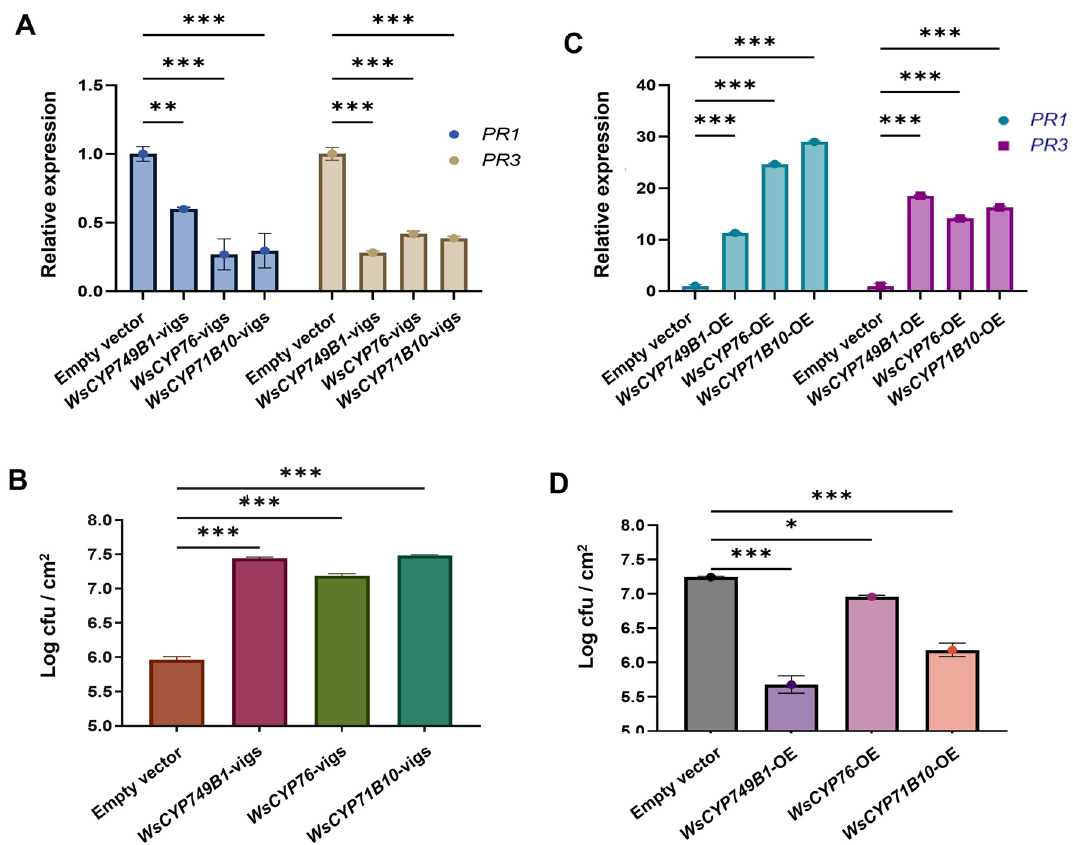
Figure 5. Effect of VIGS and overexpression of WsCYP450s on defense. Expression of PR genes in WsCYP450s silenced ( A ) and overexpressing ( C ) W. somnifera leaves. Expression levels of genes were normalized to 18S rRNA and are represented as expression relative to the empty vector (EV) control, which was set to 1. Pseudomonas syringae growth assay in WsCYP450s silenced ( B ) and overexpressing ( D ) W. somnifera leaves. Growth assay was performed by infiltrating leaves of control and VIGS plants with P. syringae (DC3000). CFU was calculated at 3 dpi of P. syringae infiltration by plating serial dilutions of leaf disc extracts. Error bars show mean ± SE of three independent experiments. Statistical significance represented as * p < 0.033, ** p < 0.002, *** p < 0.001, a significant